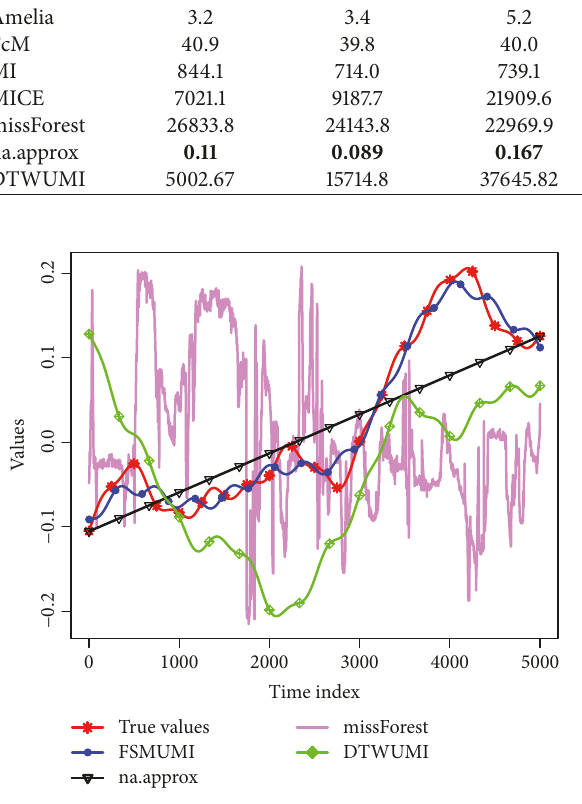
Figure 6: Visual comparison of completion data of different imputation approaches with real data on the 2 𝑛𝑑 signal of MAREL- Carnot dataset with the gap size of